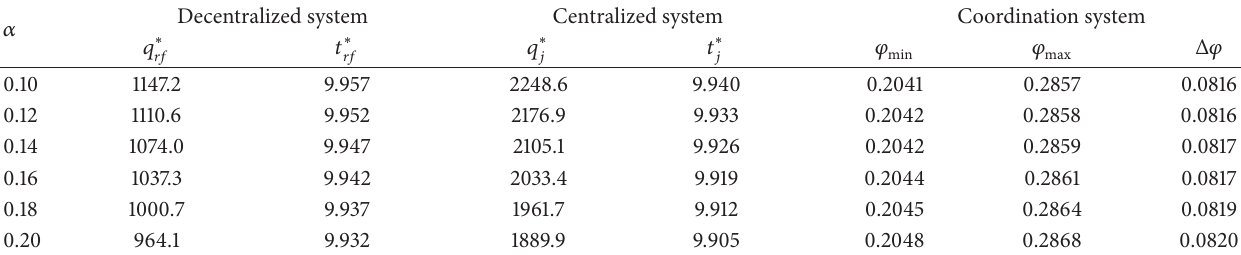
Table 3: Optimal decisions in each supply chain system with deterioration factor 𝛼 .